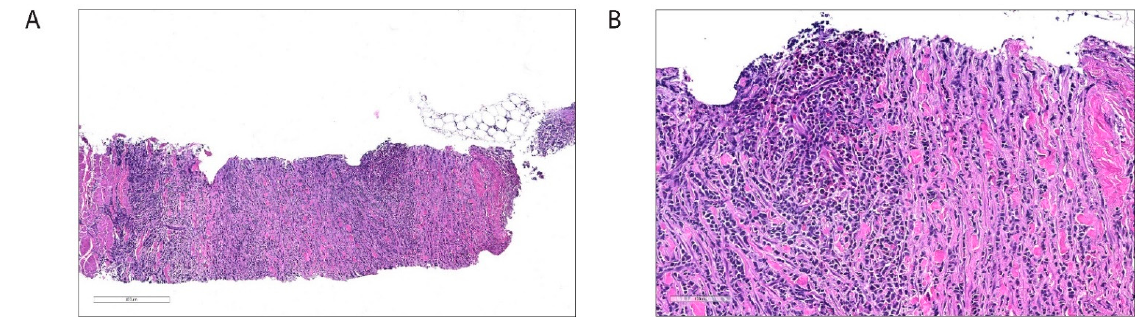
Figure 4. Histologic images of the biopsy from the retroperitoneal tumor masses, hematoxylin and eosin-stained sections. ( A ) Soft tissue with diffuse infiltration of tumor cells between striated muscle and connective tissue fibers (H&E, approx. 180 times magnification). ( B ) A higher magnification reveals tumor cells somewhat affected by crush artifacts, with immature and mature eosinophils (H&E, approx. 580 times magnification).